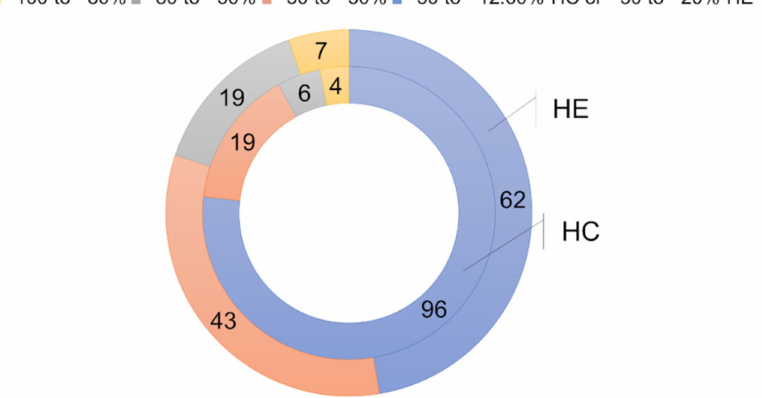
Figure 8. Donut chart showing the number of compounds in i-iv ranges of activity percent: (i) − 100 to − 80%, (ii) − 80 to − 50%, (iii) − 50 to − 30%, (iv) − 30 to − 12.60% (HC) or − 30 to − 20% (HE). Each range was considered as half-closed interval of activity percent in which the largest endpoint was included. The innermost and external rings refer to the HC and HE outcomes, respectively.